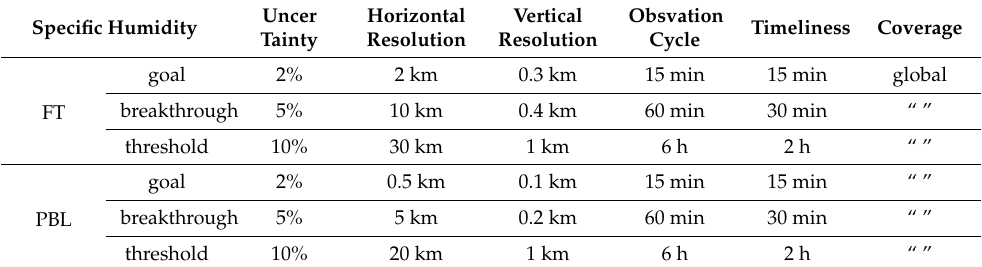
Table 1. Extract from WMO OSCAR requirements database: threshold, breakthrough and goal requirements for humidity for high resolution NWP models (where FT is the free troposphere, PBL the planetary boundary